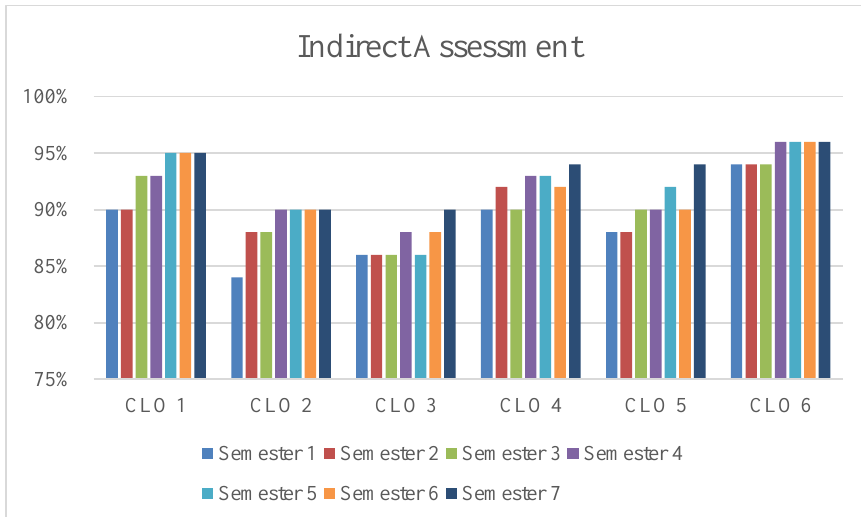
Fig. 3. The results of the indirect assessments over seven semesters